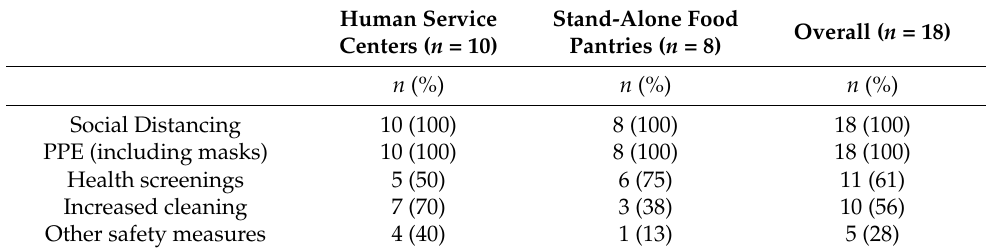
Table 2. Frequency of reported safety measures taken during food distribution by types of